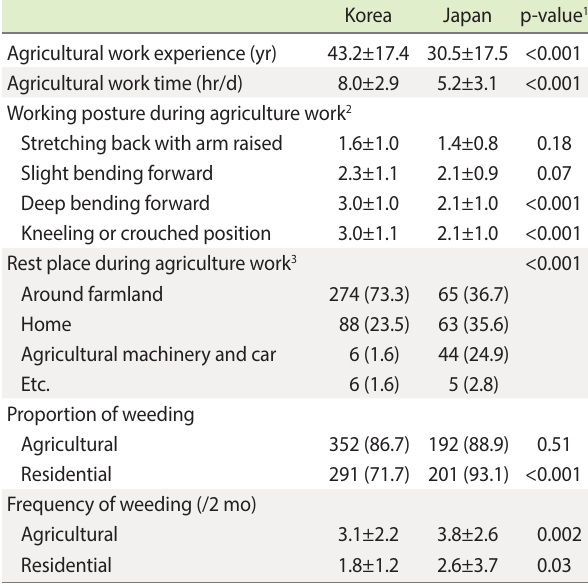
Table 2. Characteristics of agricultural work and